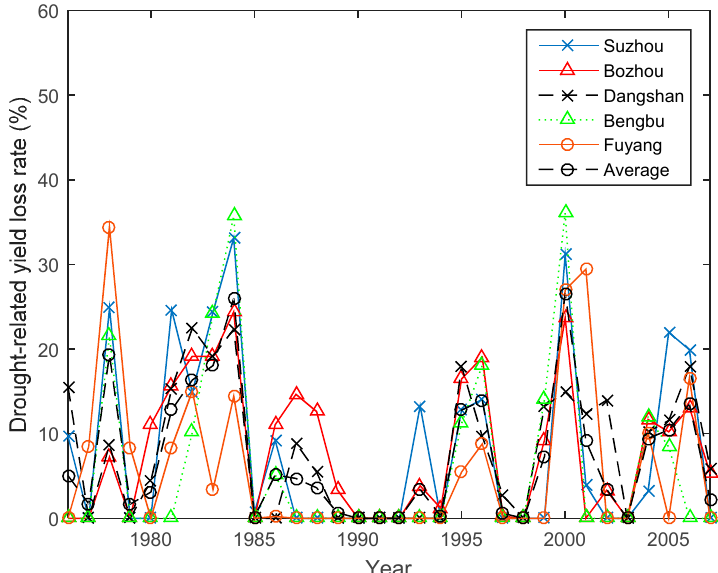
Figure 2. Drought-related yield loss rate of wheat in the study site, without drought mitigation measures and from 1976 to 2007.